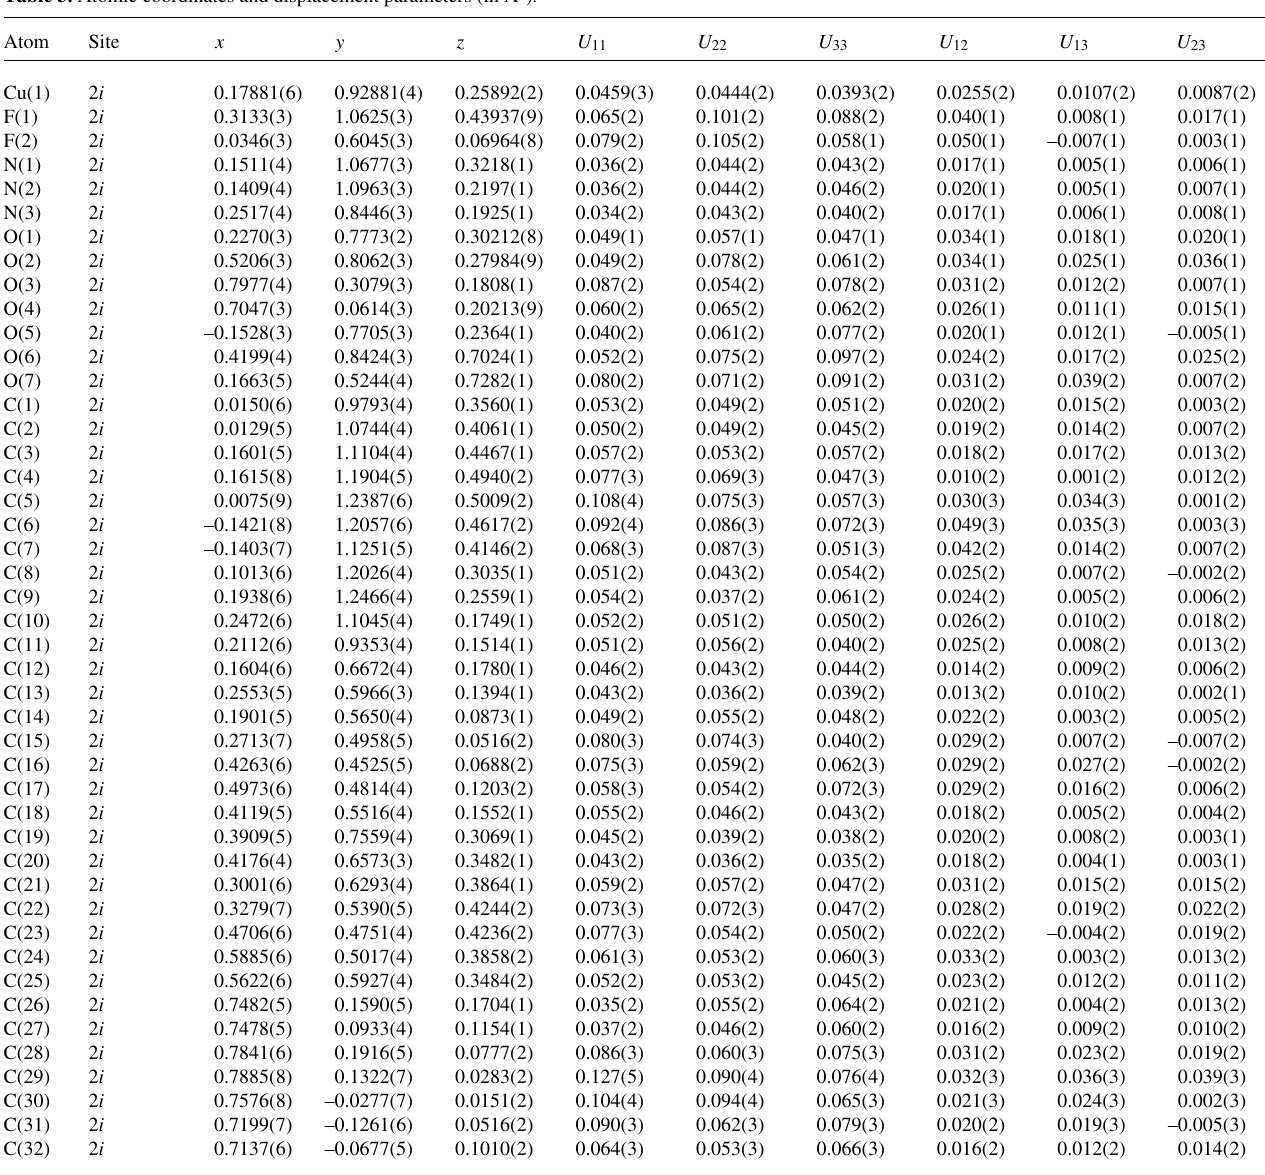
Table 3. Atomic coordinates and displacement parameters (in Å 2 )